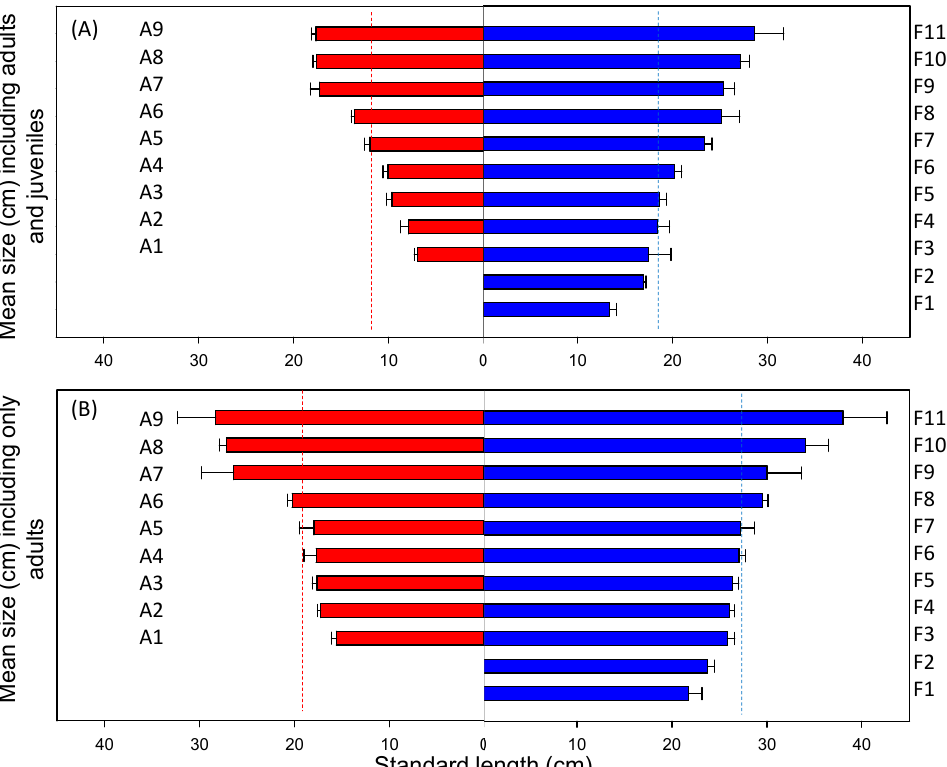
Figure 5. Size structure of the fish assemblages (mean total length cm) in lakes in the Azorean (red) and Faroe Islands (blue), including both adults and juveniles ( A ), and including only adults ( B ). Lakes are ordered from high to low average fish size. Lake ID according to Table 1, deviation bars represent SE and dotted lines represent the mean.